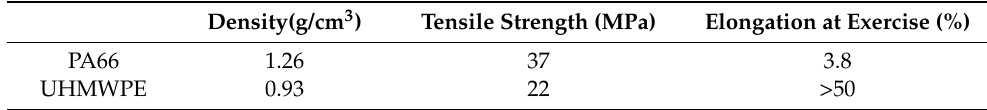
Table 1. The properties of PA66 and UHMWPE.